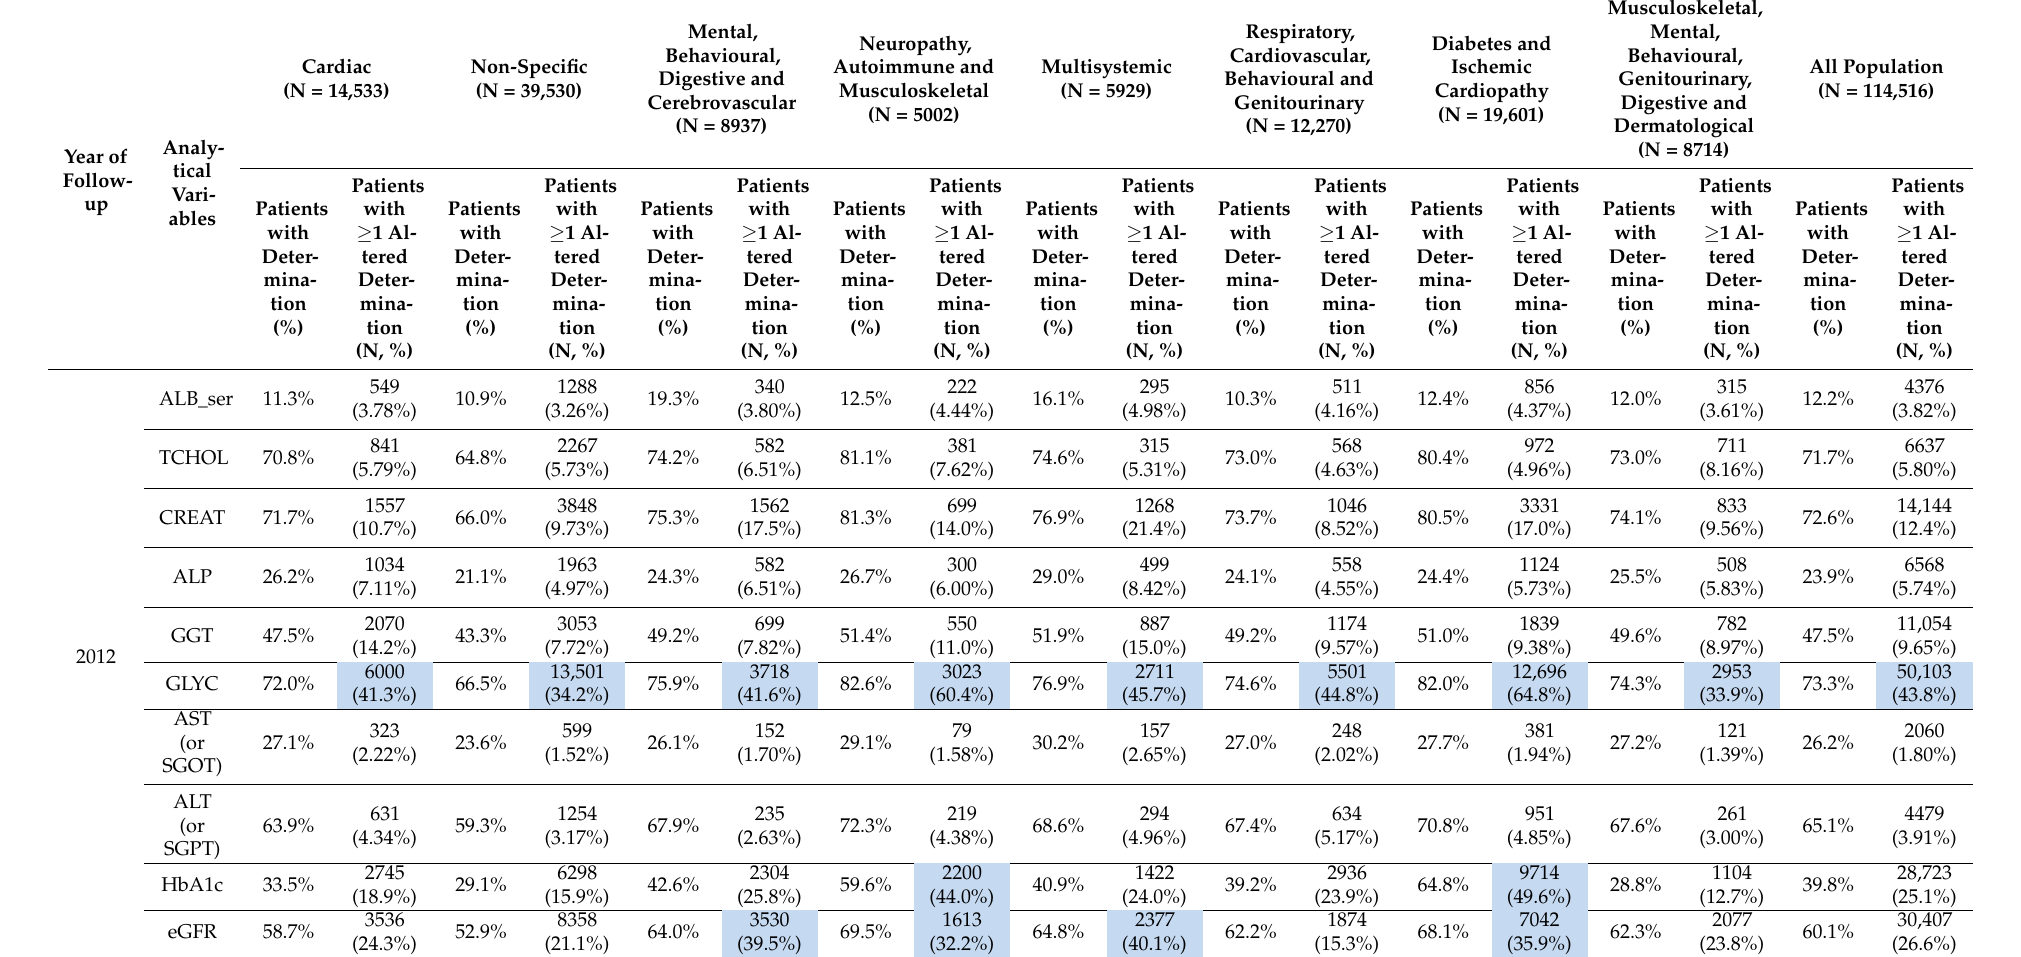
Table 2. Average of analytical determinations and patients by pattern with at least one adverse